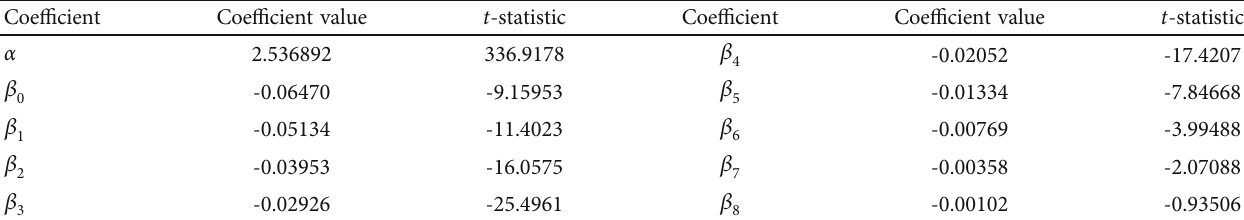
Table 3: Regression results of the distributed lag model with distal